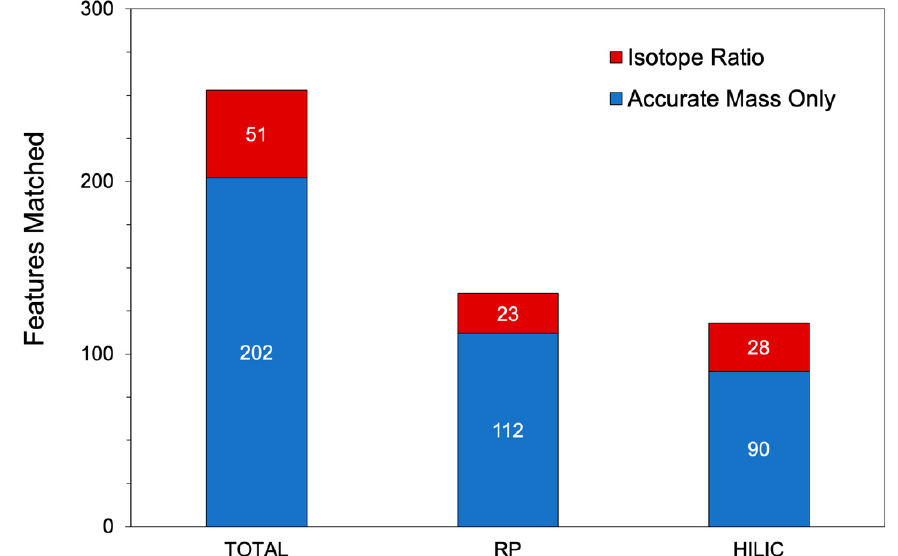
Figure 4. A summary of metabolite features MS_FBA-matched to the predicted metabolites generated from the PyFBA metabolic model with either accurate mass only (blue) or isotope ratio (red). The total column is the combination of both RP positive mode and HILIC negative runs, without excluding duplicate features between